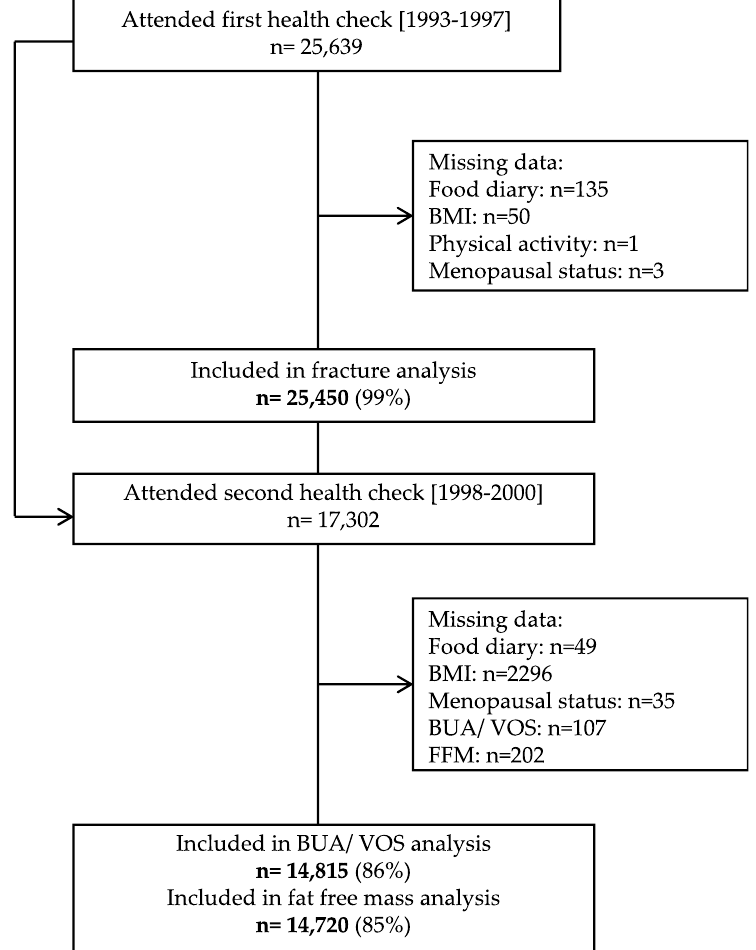
Figure 1. A flow chart detailing participant recruitment for the European Prospective Investigation of Cancer.